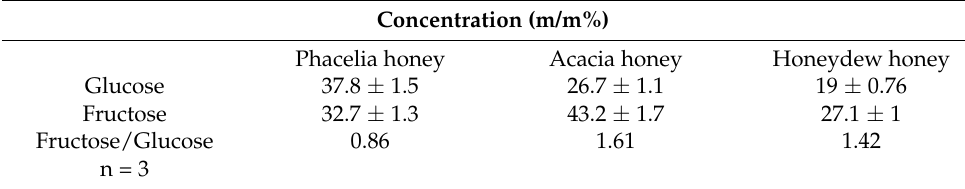
Figure 4. CZE-LEDIF determination of APTS-labeled sugars in model solutions and in honeys. ( A ) G7 malto-oligosaccharide ladder, ( B ) mixture solution of arabinose (1), xylose (2), ribose (3), galactose (4), maltose (5), ( C ) phacelia honey, ( D ) acacia honey, ( E ) honeydew honey. The analysis conditions were the same as stated at Figure 2B. Table 2. The comparison of fructose and glucose content and their proportion in phacelia honey, acacia honey, honeydew honey, n = 3 (each of them). The analysis conditions were the same as stated at Figure